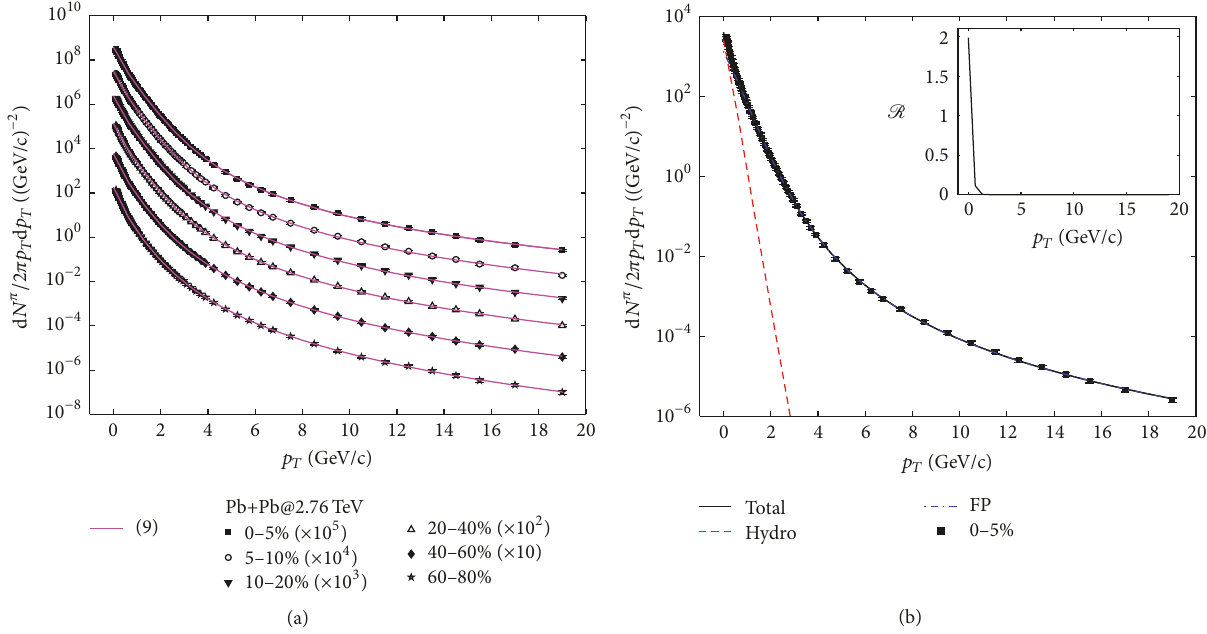
Figure 3: Fitting results using the new two-component distribution (9) for (a) 𝜋 + + 𝜋 − , while in (b) the red (dashed) and blue (dash-dotted) lines show the hydrodynamic term (hydro) and the generalized Fokker-Planck term (FP) at centrality 0–5%, respectively. The inset is for the ratio of the two terms; see the context. Data are taken from ALICE